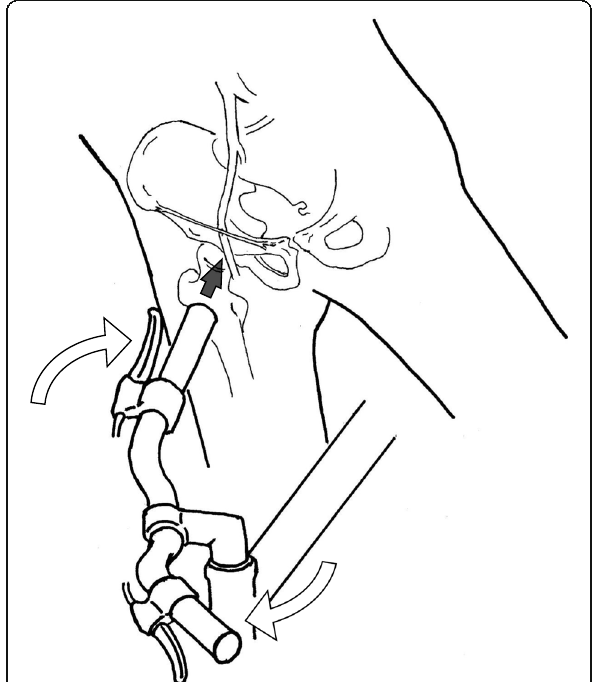
Fig. 4 Mechanism of the bicycle handlebar injury. The bicycle collided with another bicycle, and the front wheel and handlebar of the bicycle rotated in a plane perpendicular to that of the falling rider. The point of impact was the handlebar end. The CFA and EIA are both vulnerable to this impact because they pass over the superior pubic ramus and femoral head. CFA, common femoral artery; EIA, external iliac